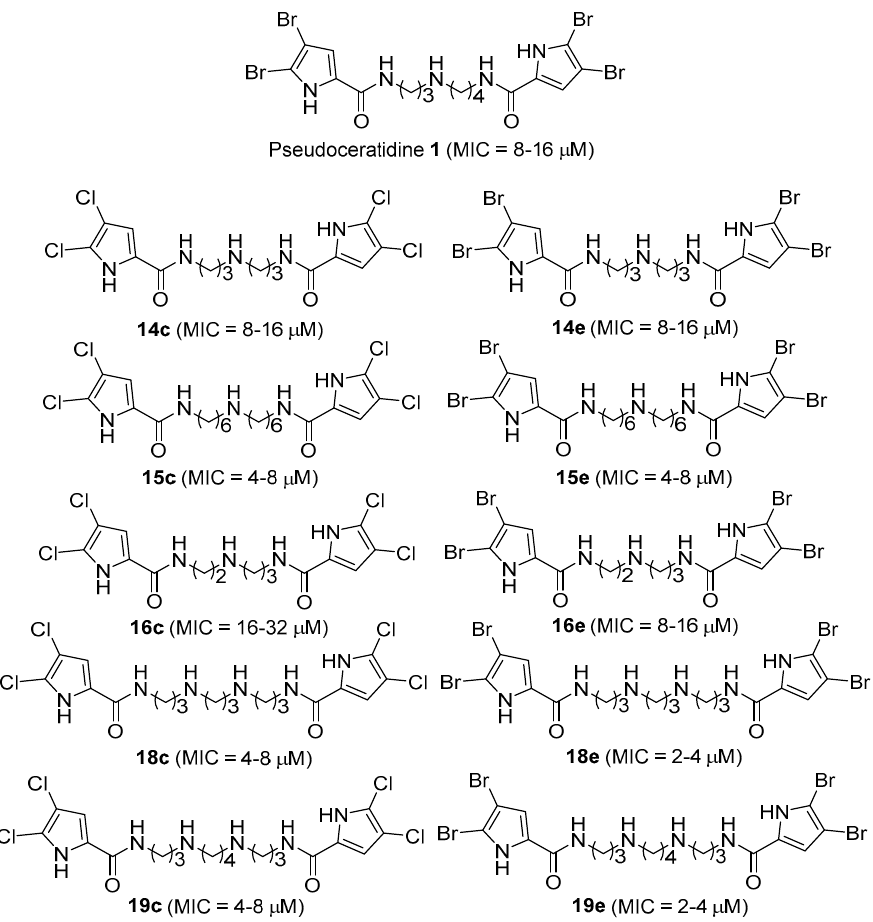
Figure 2. Pseudoceratidine 1 and the analogues shown to display comparative or more potent antibacterial activity than the natural product pseudoceratidine 1 . Gram-positive minimal inhibitory concentration (MIC) values are also given. N. B. 16c showed equivalents activity to 1 against Gram-negative